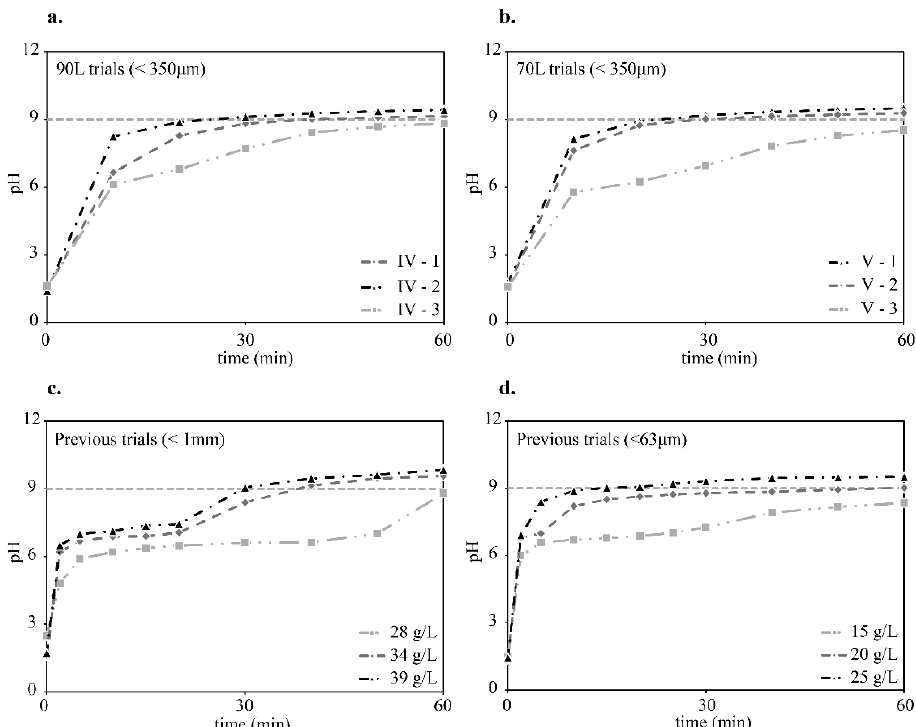
Figure 5. pH buffering obtained with the single ‐ step methodology for volumes of wastewaters of 90 L ( a ) and 70 L ( b ). The results of previous trials conducted on 1 L, with the same slag type and the same company’s industrial wastewaters, are also presented. Trials with <1 mm powders are shown in ( c ) [9], while the ones with <63 µ m powders are in ( d ) [10]. Adapted with permission from ref. [10]. Copyright 2019. Proceedings of the 6th International Slag Valorisation